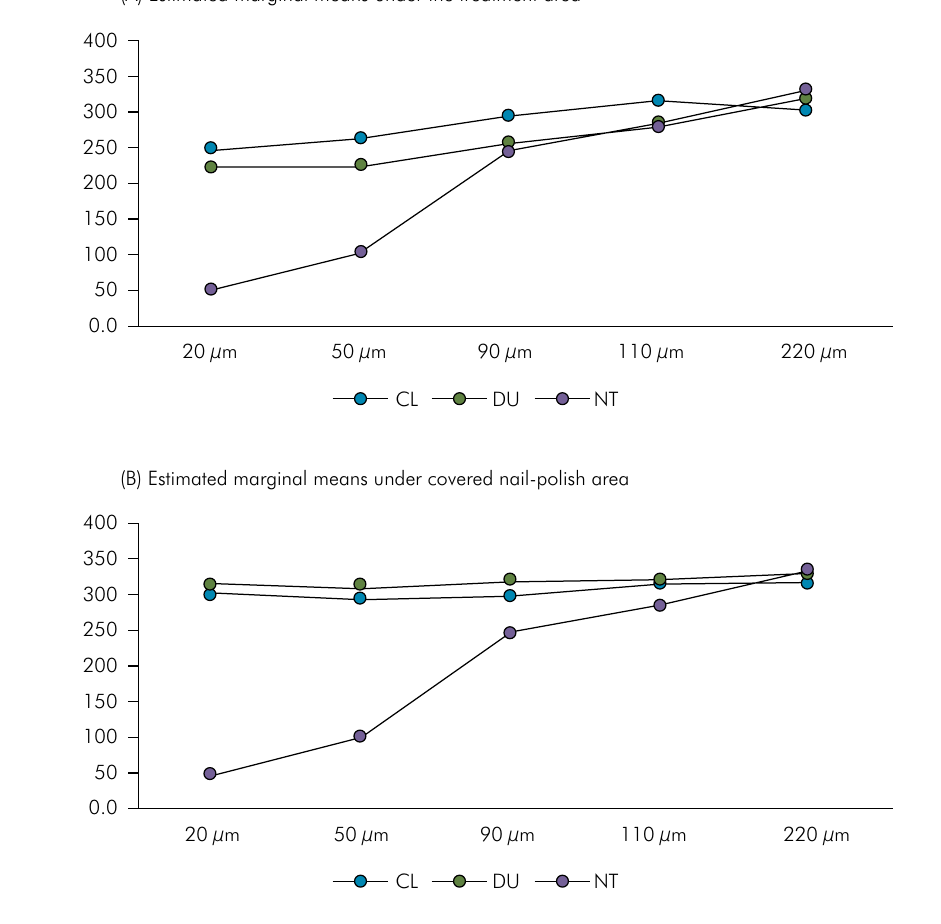
Figure 5. Mean values of enamel Knoop hardness (Kg/mm) and distance (µm) from the surface under the treatment areas (A) and under covered area